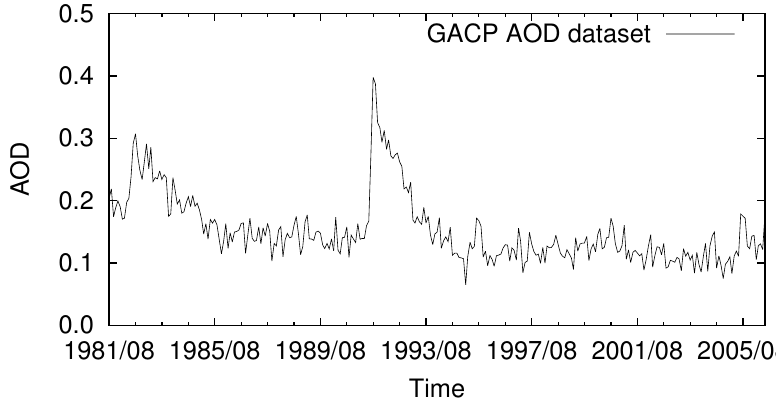
Figure 3. GACP aerosol optical depth measurements for the time period August 1981–June 2006, averaged out over the 55 clear-sky ocean